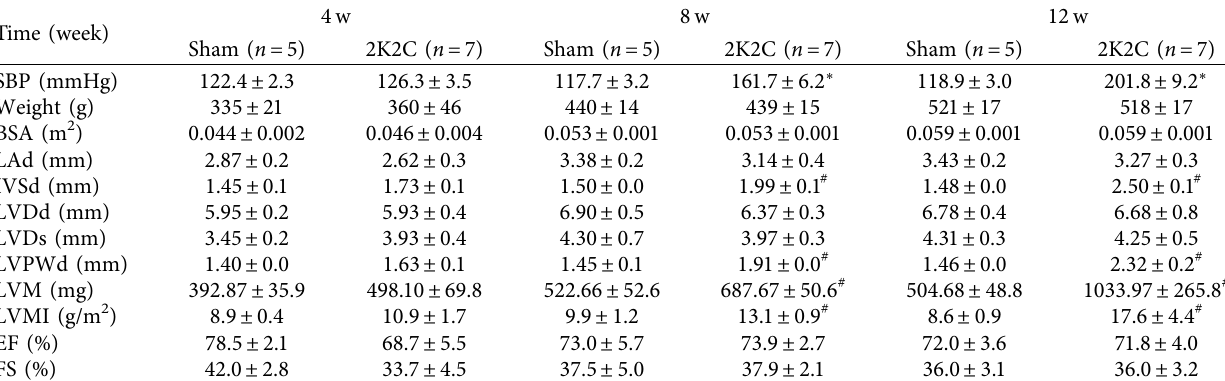
Table 1: General Clinic and Echocardiographic Findings in rats.